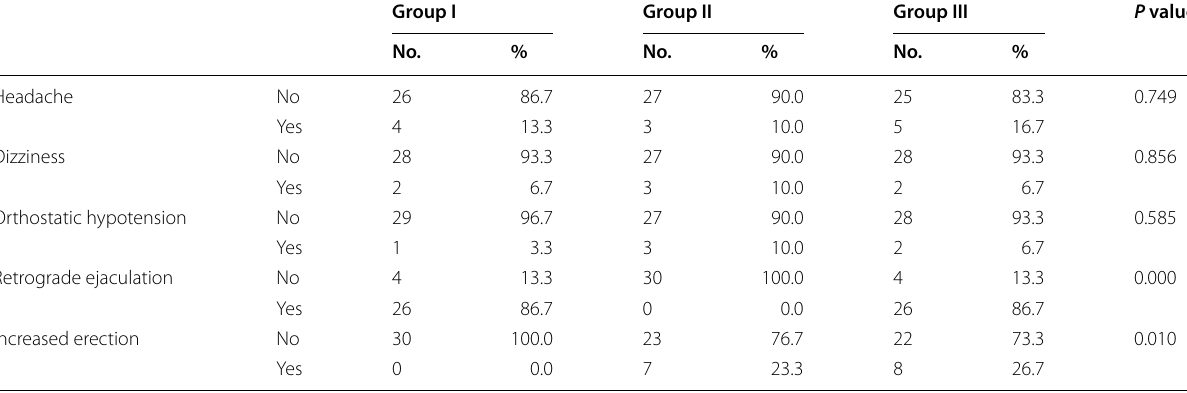
Table 3 Comparison between the groups according to common